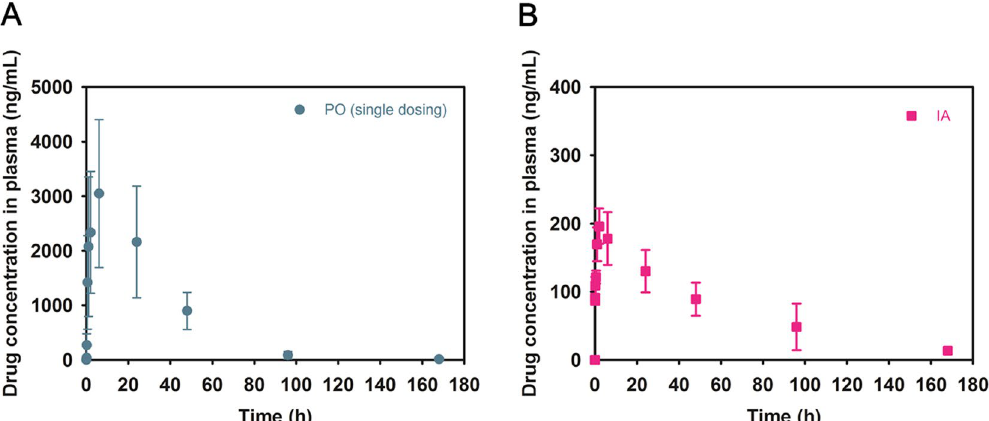
Figure 5. Pharmacokinetic profiles of SOF after oral ( A ) and IA ( B ) administration. SOF concentrations according to the time were presented. Doses of oral and IA administration were 10 and 1 mg/kg, respectively. Each point indicates mean ± SD ( n ≥ 3).